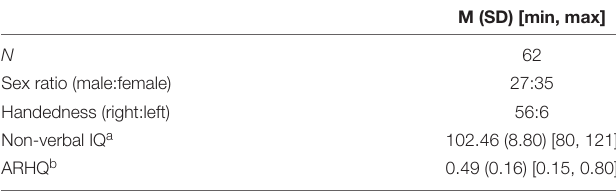
TABLE 1 | Sample characteristics.